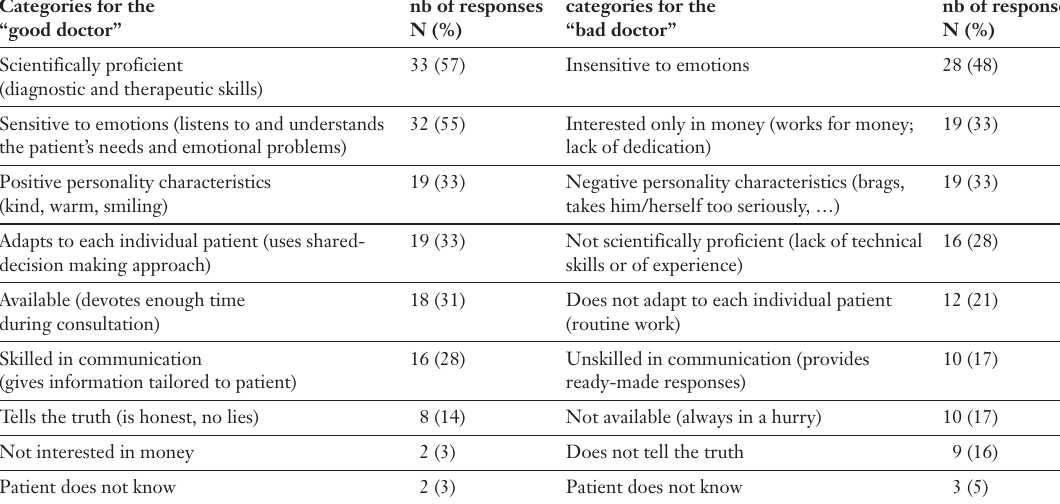
“Good” and “bad” doctors’ character- istics: patients’